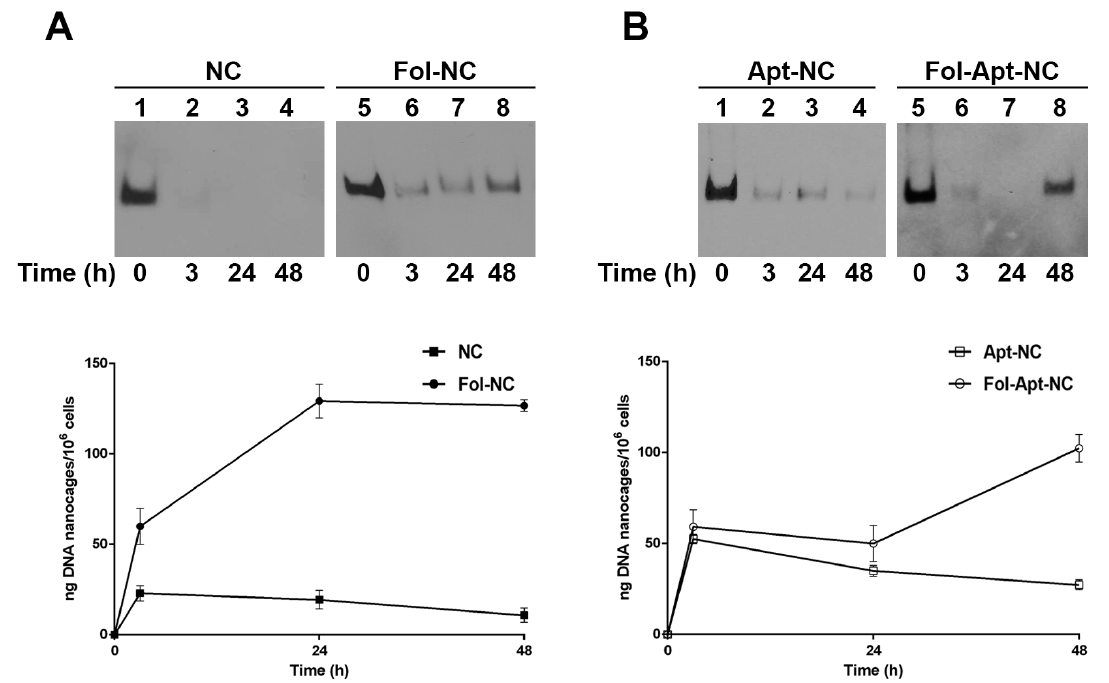
Figure 4. Intracellular stability of functionalized nanocages in MDA-MB-231 cells. Representative DNA blots of MDA-MB-231 cell extracts incubated for 3, 24, and 48 h with ( A ) NC (lanes 2, 3, and 4) or Fol-NC (lanes 6, 7, and 8) and ( B ) Apt-NC (lanes 2-3 and 4) and Fol-Apt-NC (lanes 6, 7 and 8). Biotinylated nanostructures were detected with streptavidin (HRP) – biotin reaction. 15 ng of DNA nanocages before incubation with cells (time 0) are shown in lanes 1 and 5. Histograms in lower panels show the amount of DNA nanocages, expressed in ng/10 6 cells, internalized in cells at different time points at 37 °C, as indicated. For image processing and densitometric analysis, bands were analyzed by using ImageJ software. Values, calculated by using GraphPad Prism, were expressed as a mean ± SEM.